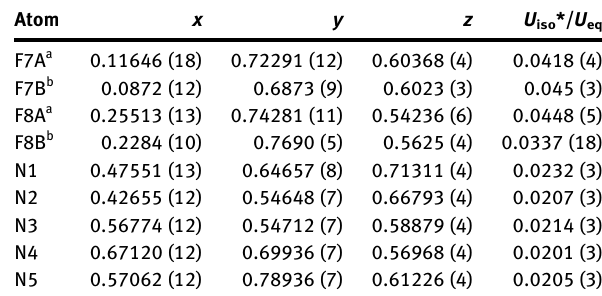
Table  : Fractional atomic coordinates and isotropic or equivalent isotropic displacement parameters (Å 